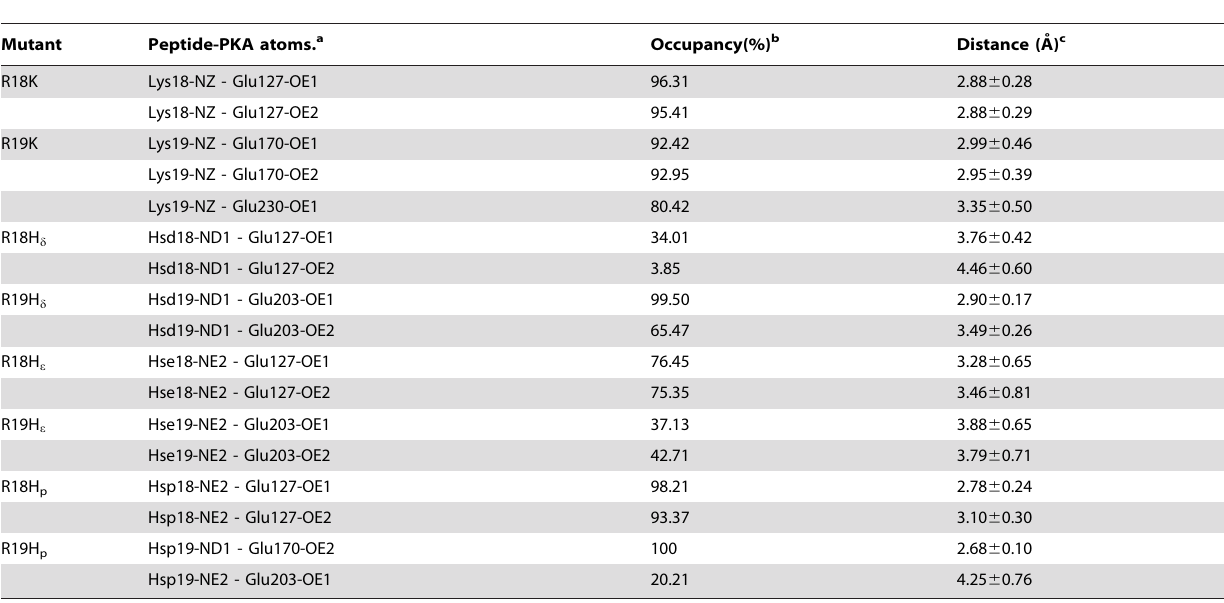
Table 3. Hydrogen-Bond occupancies analysis from the results of MD simulations for the peptide-PKA interactions between mutated amino